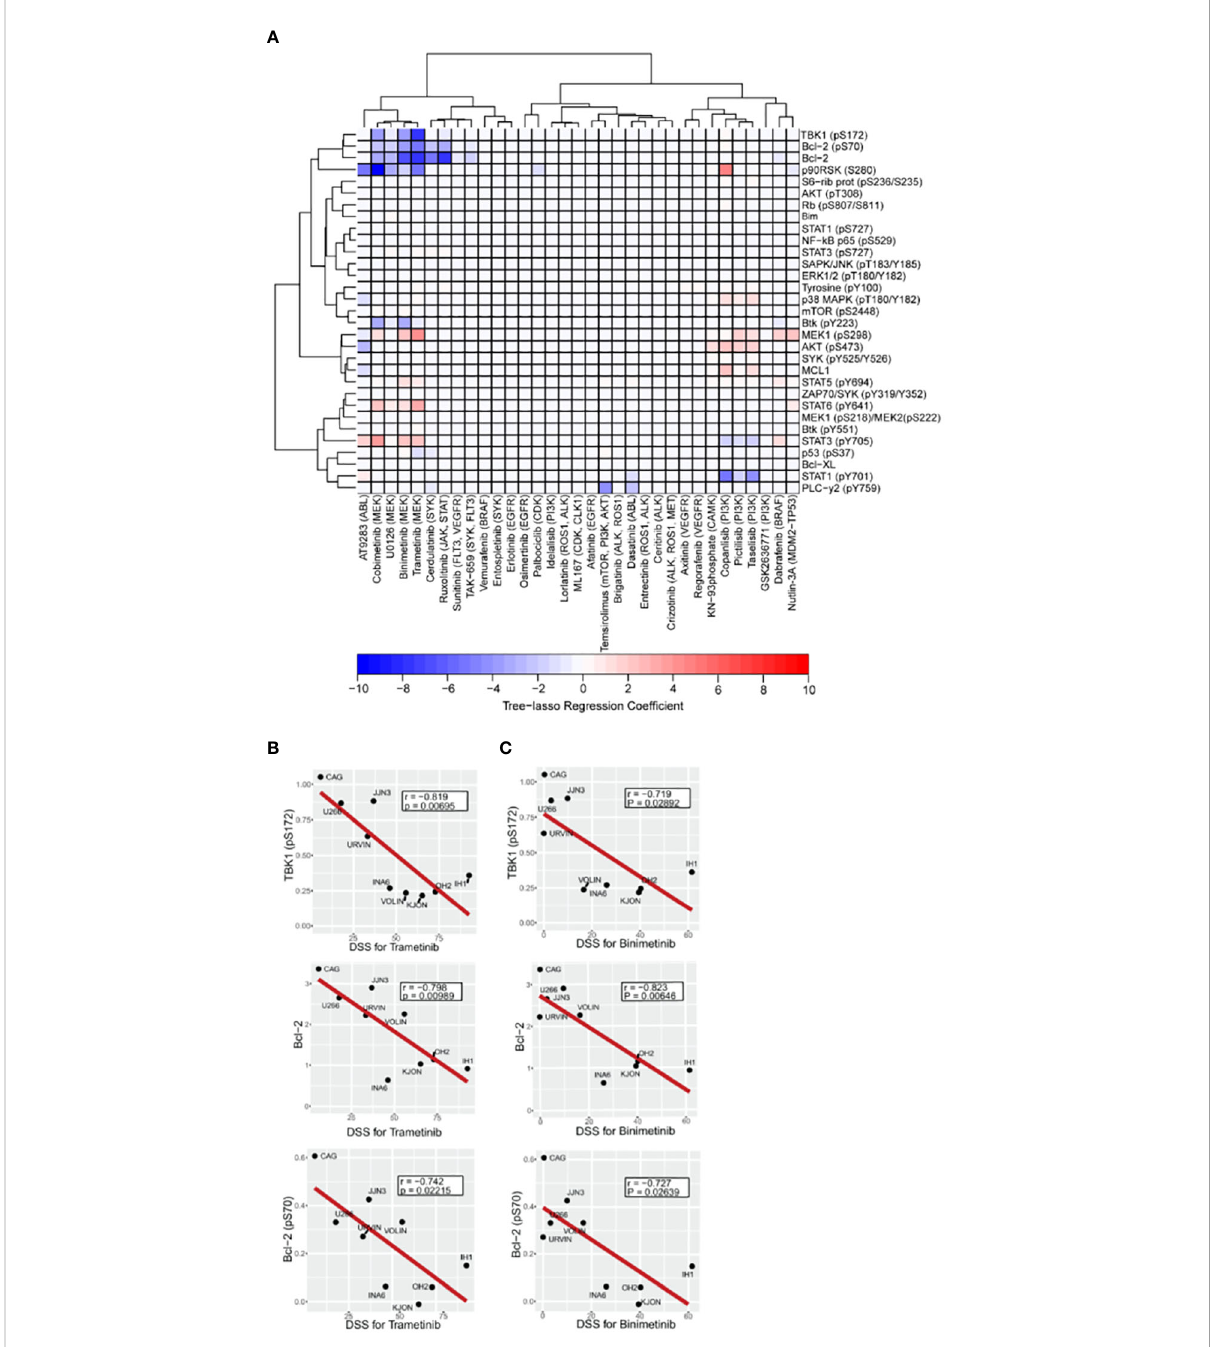
FIGURE 4 Association between drug sensitivity and expression or activation pro fi le of selected intracellular cancer-driven proteins. A – C, Freshly thawed MM cell lines (n=9) were fi xed, permeabilized and stained with antibodies against the indicated proteins or phosphoprotein epitopes (rows). Signals were analyzed by fl ow cytometry (see Materials and Methods). (A) , Heatmap of the tree-lasso regression coef fi cients for DSS as a linear function of the standardized phospho fl ow data, with proteins as rows and drugs as columns. Positive and negative regression coef fi cients are represented in shades of red and blue, respectively. B,C, Pearson correlation plots for DSS to the indicated MEK inhibitors trametinib (B) and binimetinib (C) versus three signaling readouts inversely associated with drug